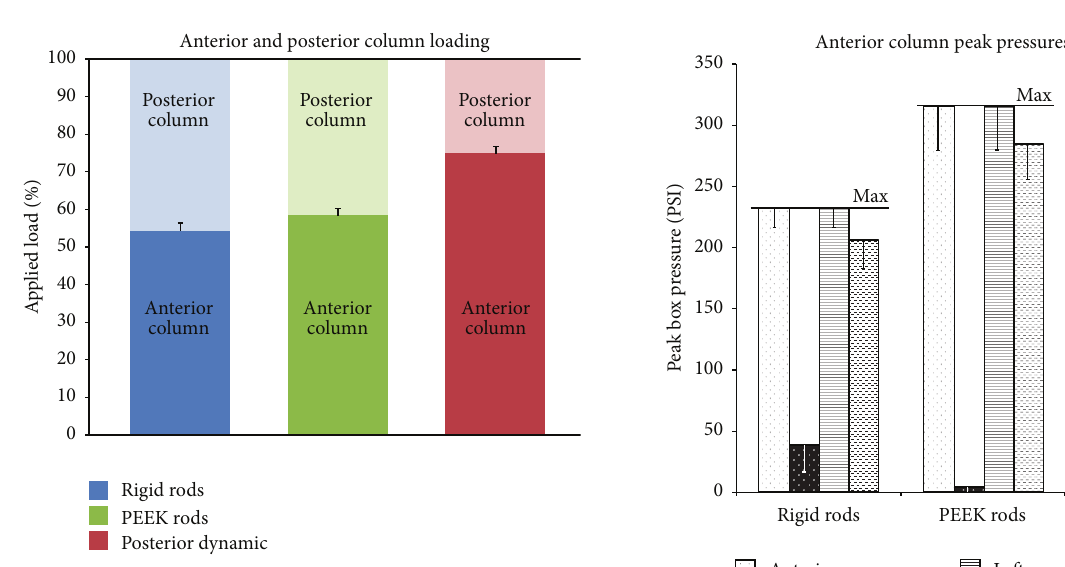
Figure 8: Anterior and posterior columns load-sharing. The bars represent standard deviations in measured anterior column load.